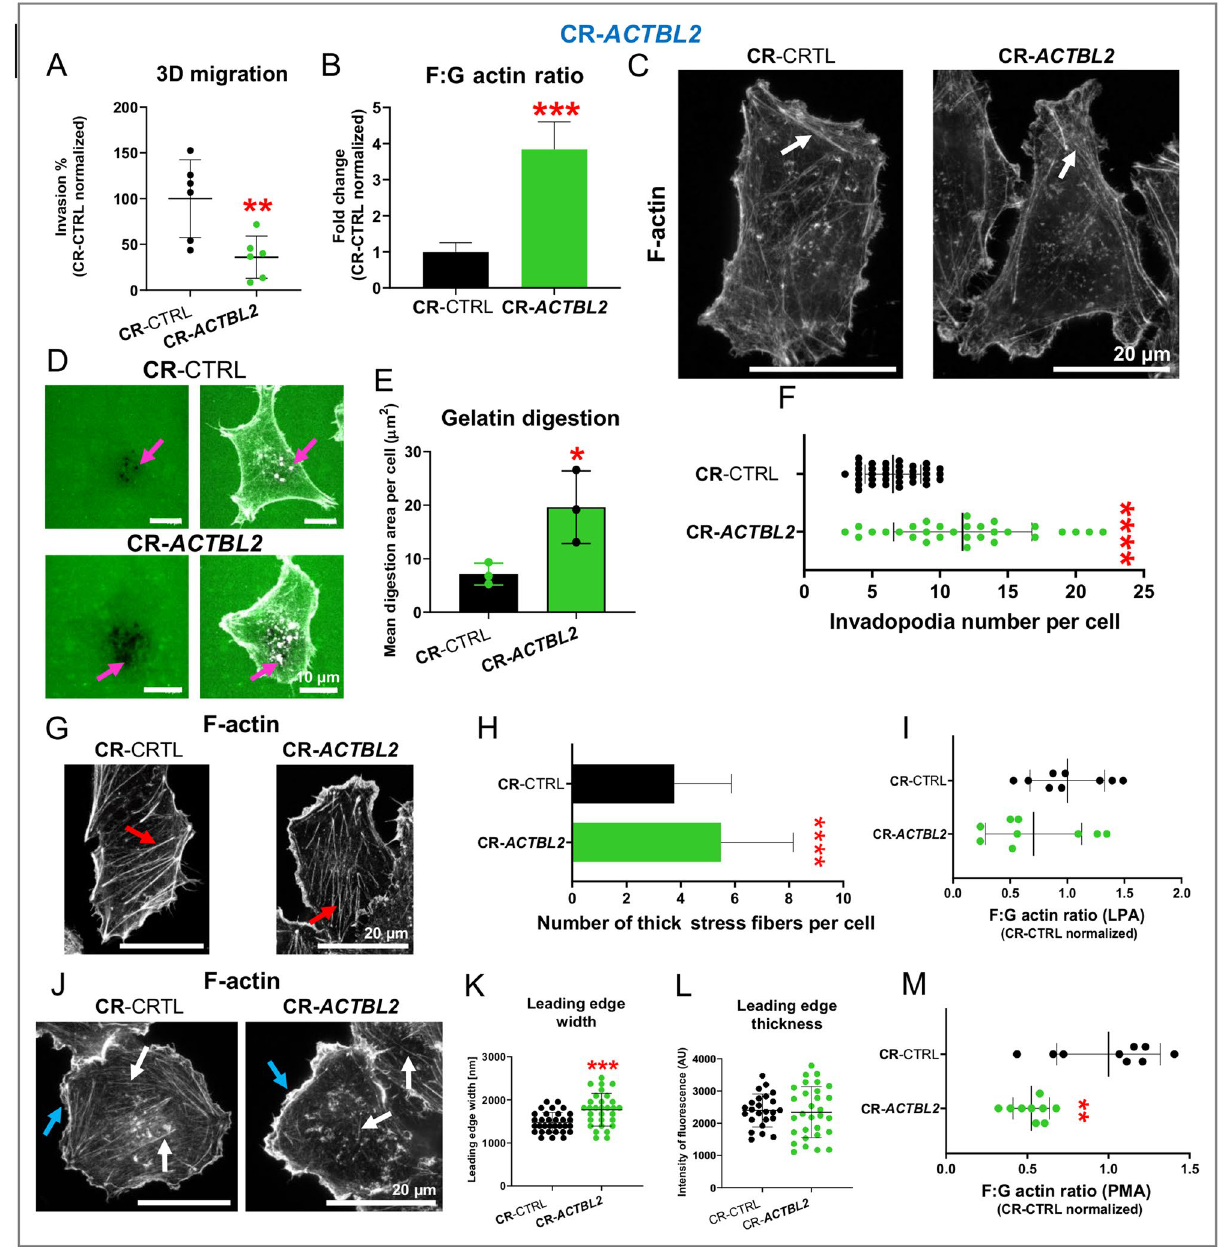
Figure 8. Invasion potential of CR- ACTBL2 clones was diminished, accompanied by alterations in actin cytoskeleton architecture upon LPA and PMA treatment. ( A ) Invasion/3D migration potential was measured for CR-CTRL and CR- ACTBL2 cells (n = 6). ( B ) 24 h after seeding, the cells were lysed, and the F:G actin ratio was estimated (n = 8–9). ( C ) STED microscopic analysis of CR-CTRL and CR- ACTBL2 cells. The cells were fixed and stained with phalloidin-Abberior Star Red. White arrows highlight stress fibers. ( D ) The cells were seeded on fluorescently labeled gelatin. 12 h later, the cells were fixed and stained with phalloidin Alexa Fluor 568. Pink arrows point at invadopodia and the digested area. The digested area ( E ) and the number of invadopodia ( F ) were calculated based on captured images (n = 30). ( G ) After 24 h of starvation, the studied clones were treated for 10 min with 1 μM LPA. Next, they were fixed, stained with phalloidin-Abberior Star Red, and subjected to STED microscopy. Red arrows point at thick actin bundles/stress fibers. ( H ) Thick microfilament bundles were calculated from images taken using a confocal microscope (n = 60). Representative photos are shown in Fig. S16B. ( I ) Upon LPA treatment, the cells were lysed and subjected to F:G actin ratio assay (n = 9). ( J ) 24 h upon starvation, the cells were incubated with 100 nM PMA for 5 min. Next, they were fixed and stained with phalloidin-Abberior Star Red. The following photos were taken with STED microscopy. Blue arrows highlight lamellipodia, and white arrows indicate stress fibers. The leading-edge width ( K ) and thickness ( L ) were calculated based on confocal microscopy images (n = 30). Representative photos are shown in Fig. S16C. ( M ) The F:G actin ratio was measured for CR-CTRL and CR- ACTBL2 cells after the addition of 100 nM PMA for 5 min (n = 9). Results are expressed as the mean ± SD; p ≤ 0.05 (*), p ≤ 0.01 (**), p ≤ 0.001 (***), p ≤ 0.0001